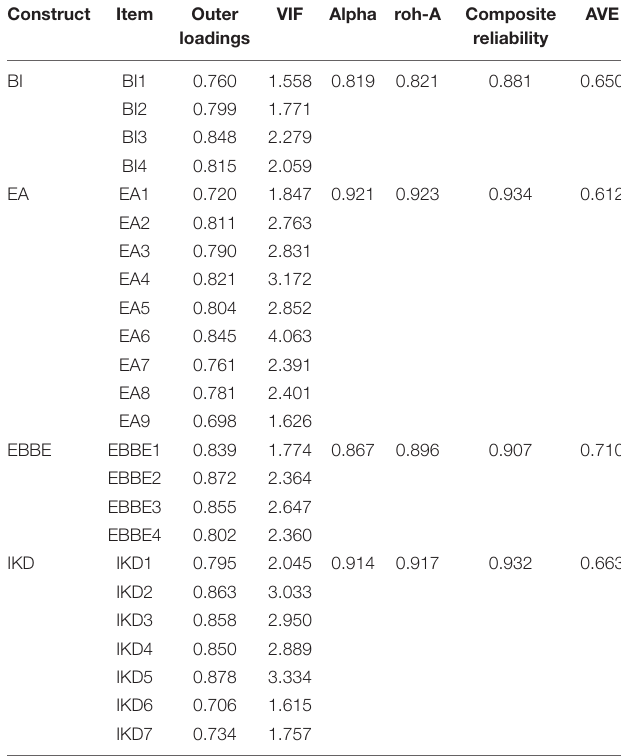
TABLE 2 | Reliability and validity of the study